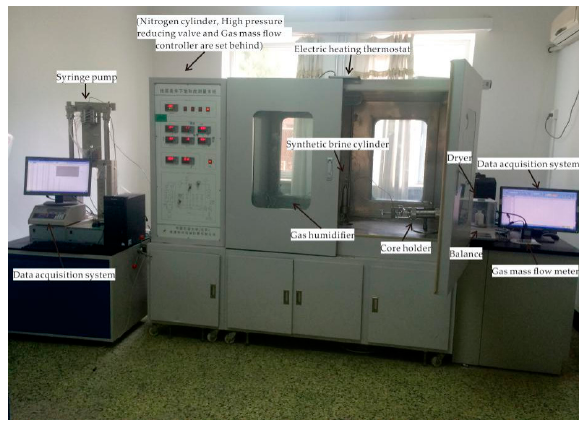
Figure 2. Image of displacement experiment system.